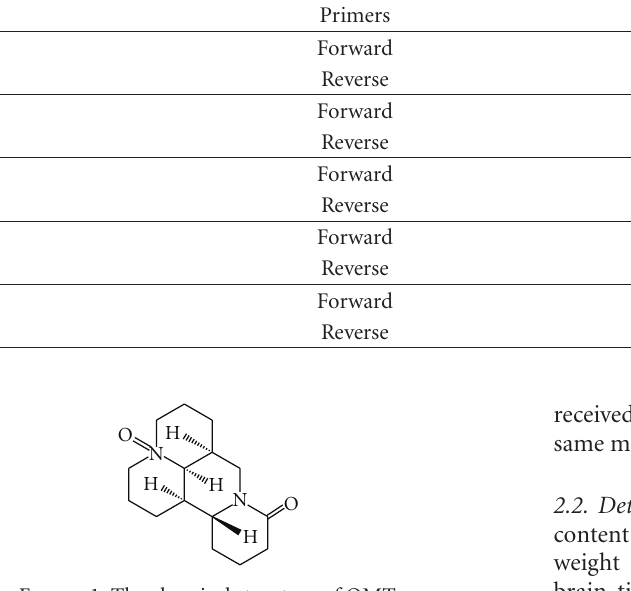
Figure 1: The chemical structure of